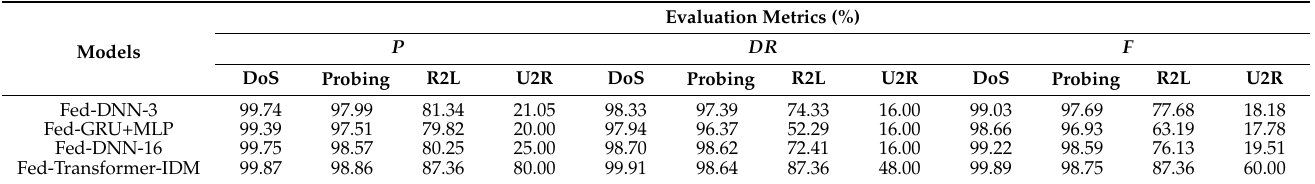
Figure 4. The test accuracy comparison at each global iteration. Table 7. The values of evaluation metrics of each attack category for different global models.